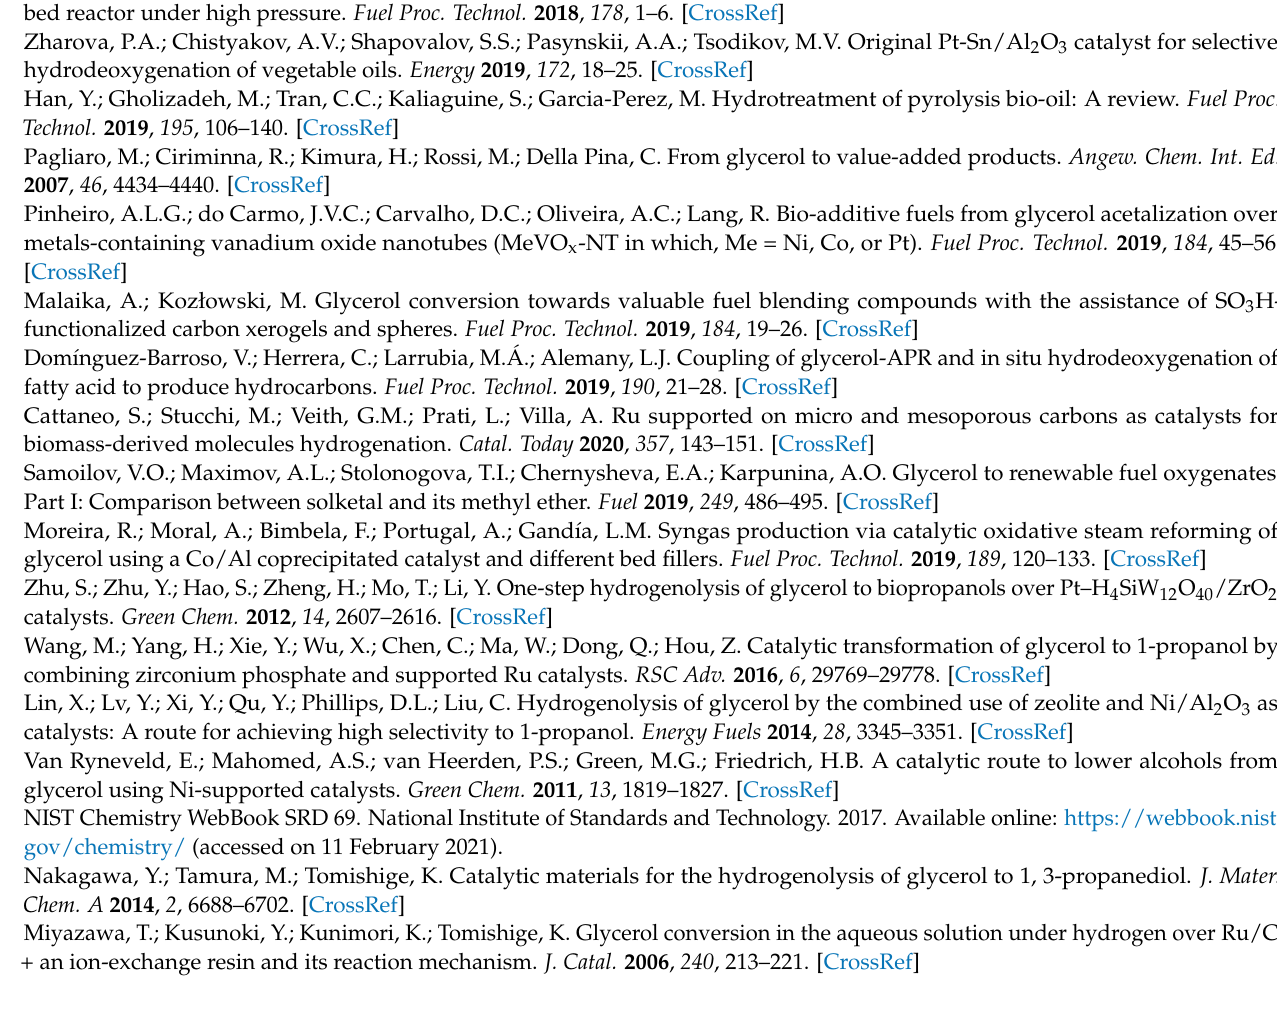
catalyst, Figure S11: Chromatogram of the liquid products obtained in the glycerol hydrogenolysis over the 16%Ni/(20%WO 3 -TiO 2 ) catalyst in the optimum reaction conditions. Process conditions: Catalyst amount (grains 0.25–0.50 mm)—2 cm 3 /1.6 g; Glycerol concentration in the